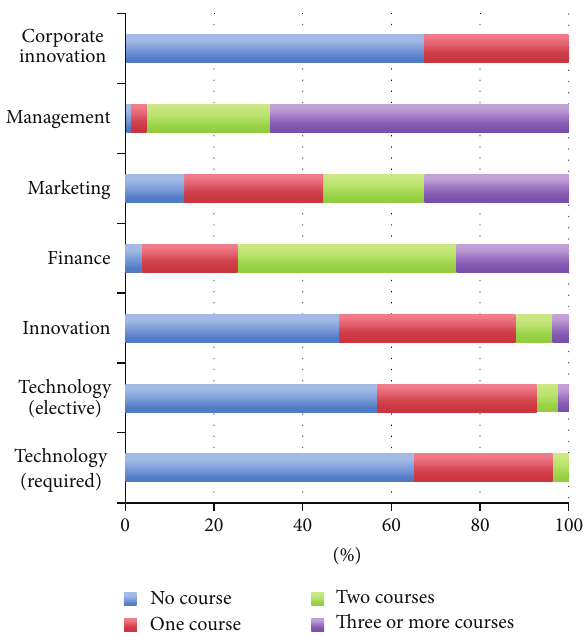
Figure 2: Courses offered by entrepreneurship